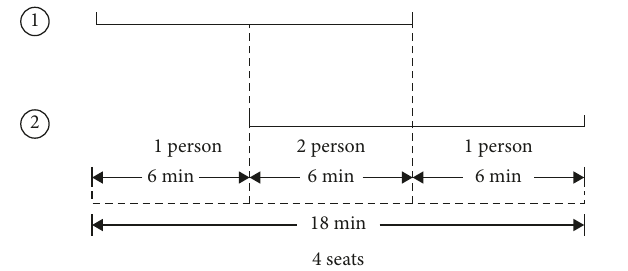
Figure 5: Recommended indicator 2: example of